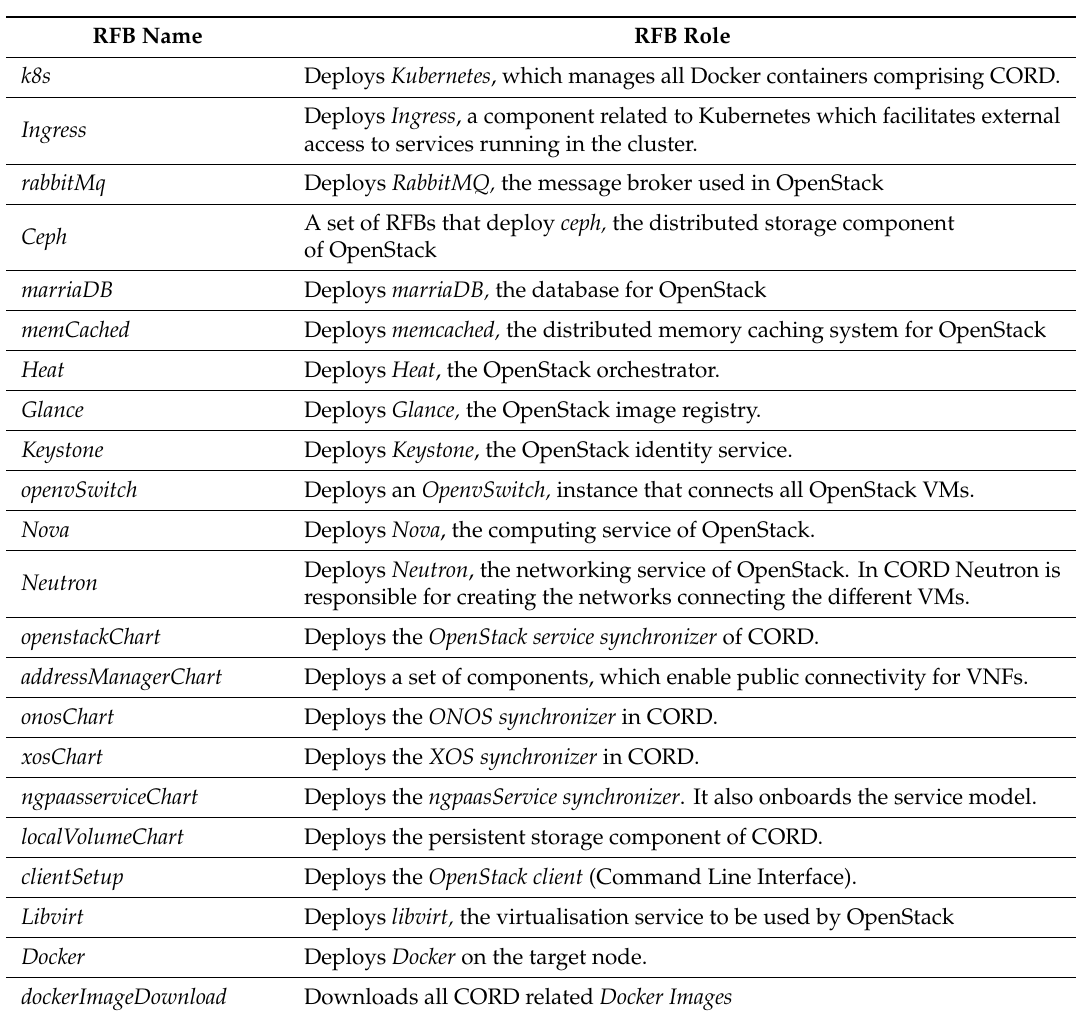
Table 4. List of Deployment